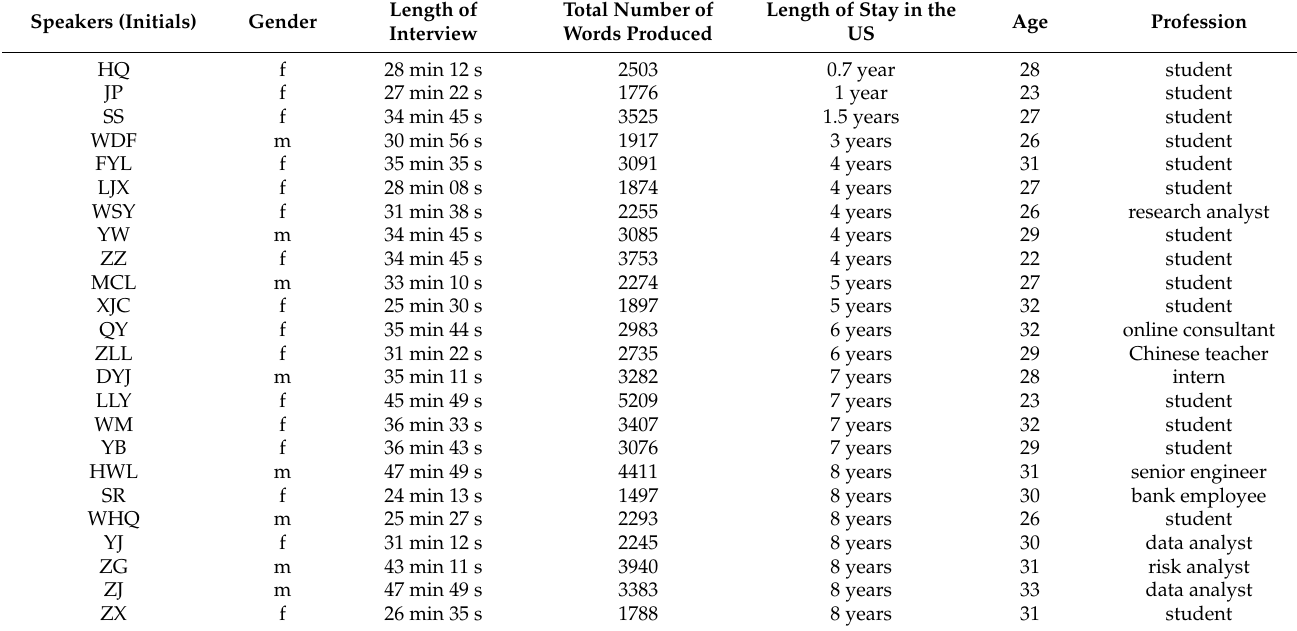
Table 1. The detailed information of the